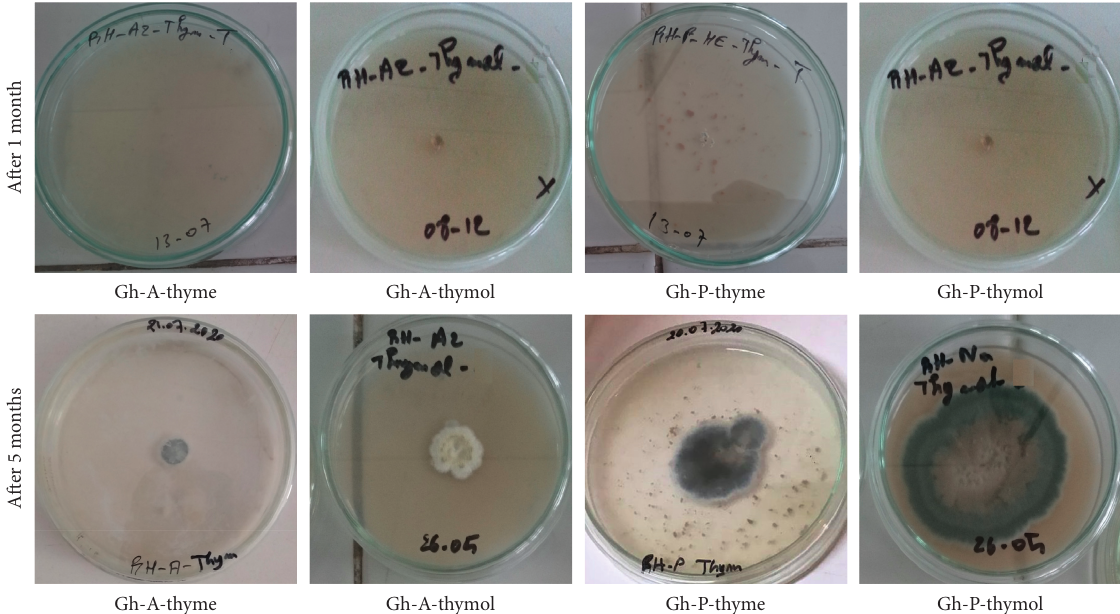
Figure 4: Inhibition rate of the prepared formulation against Penicillium , after 15 days incubation at 25 ° C.